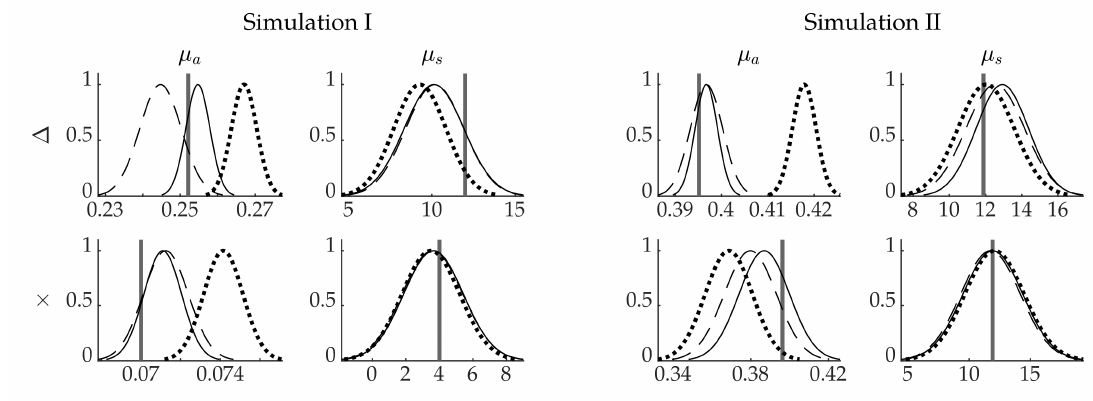
Figure 4. Marginal probability densities of the posterior distributions. True value (solid vertical line), the approximation of the posterior distribution of MAP-REF reconstructions (solid line), MAP-CEM reconstructions (dotted line) and MAP-EEM reconstructions (dashed line). The first and second column present the absorption and scattering of the simulation with smooth inclusions. Third and fourth columns present the absorption and scattering of the simulation with blood-vessel-mimicking inclusion. First row present the results in the points marked with (cid:52) and second row with × as shown in Figures 1 and